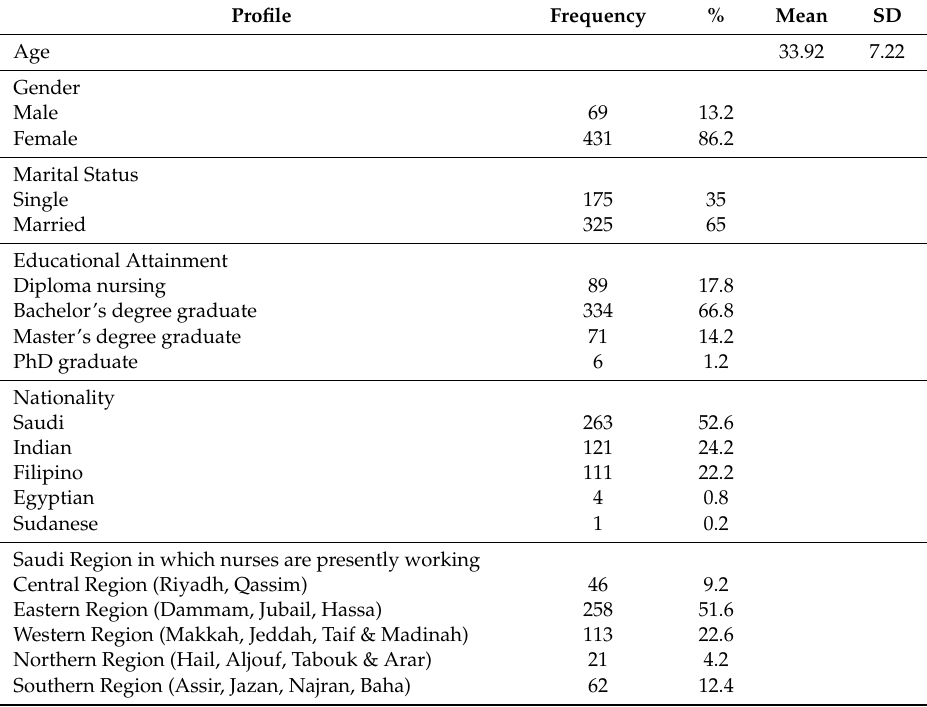
Table 1. Nurses’ demographic and work-related characteristics ( n =